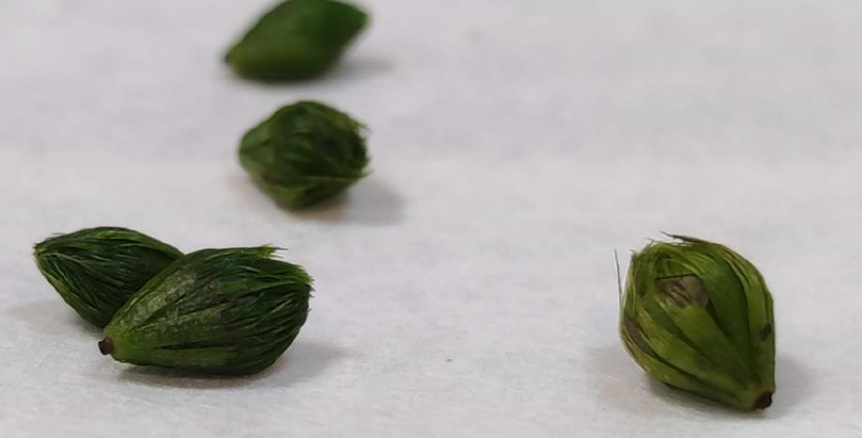
Figure 3. Aldrovanda vesiculosa turions taken from natural